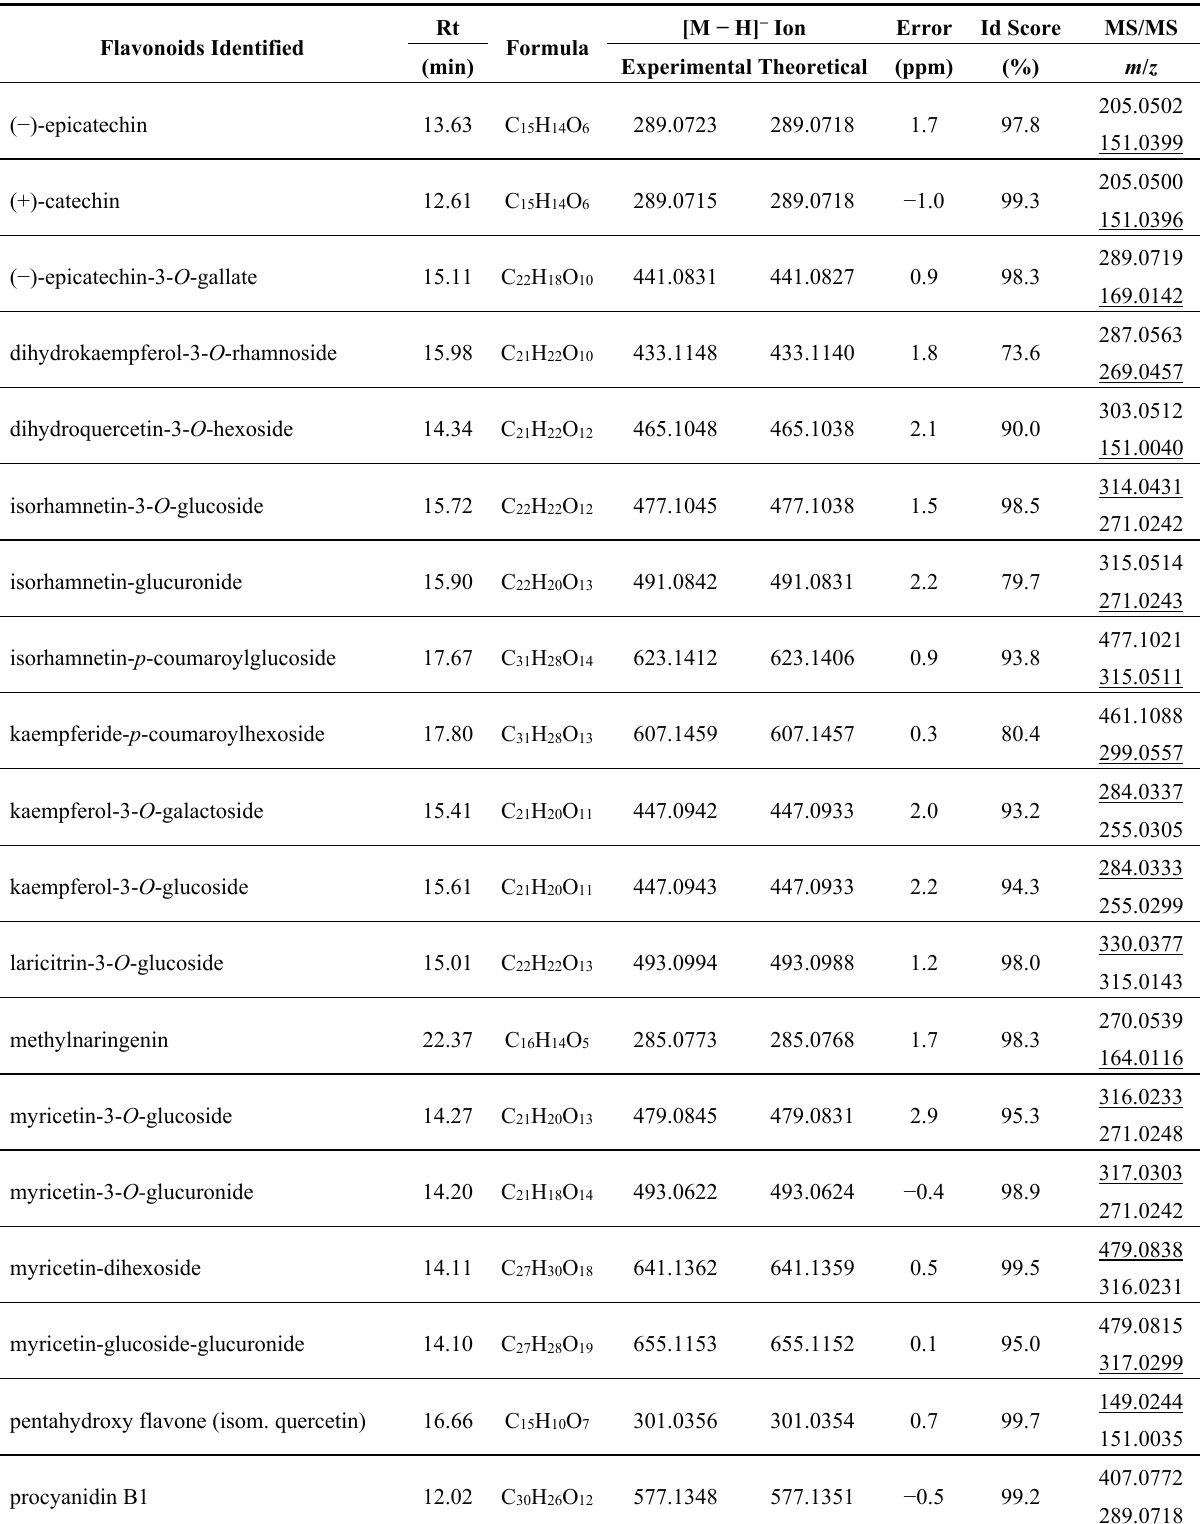
Table 1. [M − H] − ion of non-anthocyanic flavonoids identified in the five hybrid grape samples studied. ppm: mass error; Id score: overall identification score calculated on the isotopic pattern signals of the compound. MS/MS, main identification fragments (underlined, the more